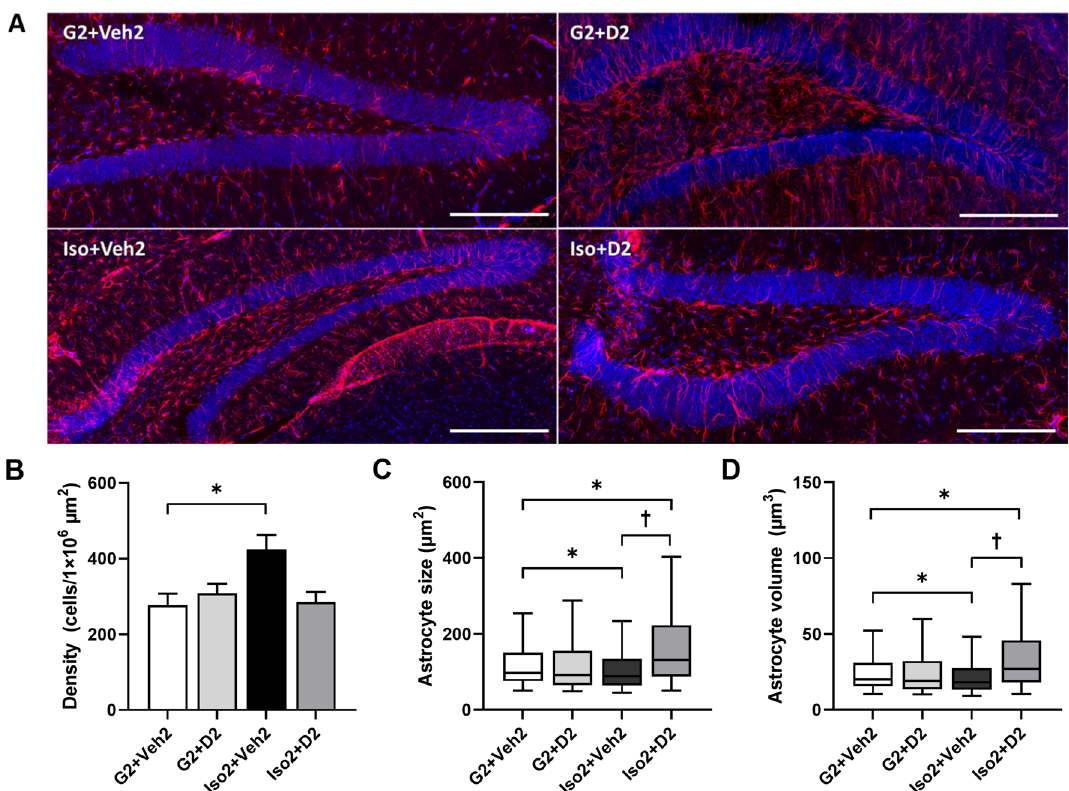
Figure 2. Astrocyte density and size in the dentate gyrus. ( A ) 20X Airyscan super resolution images of single or near-single astrocytes in the dentate gyrus of mice: blue = DAPI, nucleus; red = GFAP, astrocytes. Scale bar = 200 µm. ( B ) Number of astrocytes per sample normalized to DG area. Data shown as mean + SEM. Two- way ANOVA with multiple comparisons, Holm-Sidak method. Astrocyte size in µm 2 ( C ) and µm 3 ( D ). Data shown as box plot, where center line is the median, limits are the interquartile range (IQR), and whiskers are the minimum and maximum. Kruskal–Wallis one-way ANOVA on ranks with multiple comparisons, Dunn’s method. For all graphs, N = 3–4 mice analyzed per group, one section per mouse. G2 + Veh2: 2-week grouped plus 2-week grouped with vehicle treatment; G2 + D2: 2-week grouped plus 2-week grouped with DHM administration; Iso2 + Veh2: 2-week SoIso plus 2-week SoIso with vehicle treatment; Iso2 + D2: 2-week SoIso plus 2-week SoIso with DHM administration. *, P ≤ 0.05; †, P ≤ 0.05 vs Iso2 + D2; ‡, P ≤ 0.05 vs G2 +